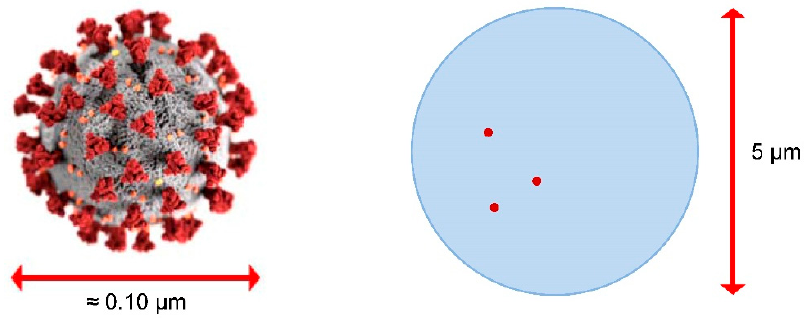
Figure 1. Dimensions of SARS-CoV-2 [7] and its possible distribution within a bioaerosol. The virus uses the bioaerosol as a means of transport and, depending on the bioaerosol’s size, can affect different organs of the recipient body, which in turn influences the